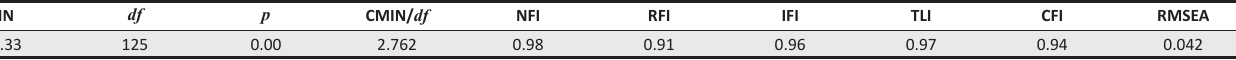
TABLE 2: Measures for goodness-of-fit (measurement